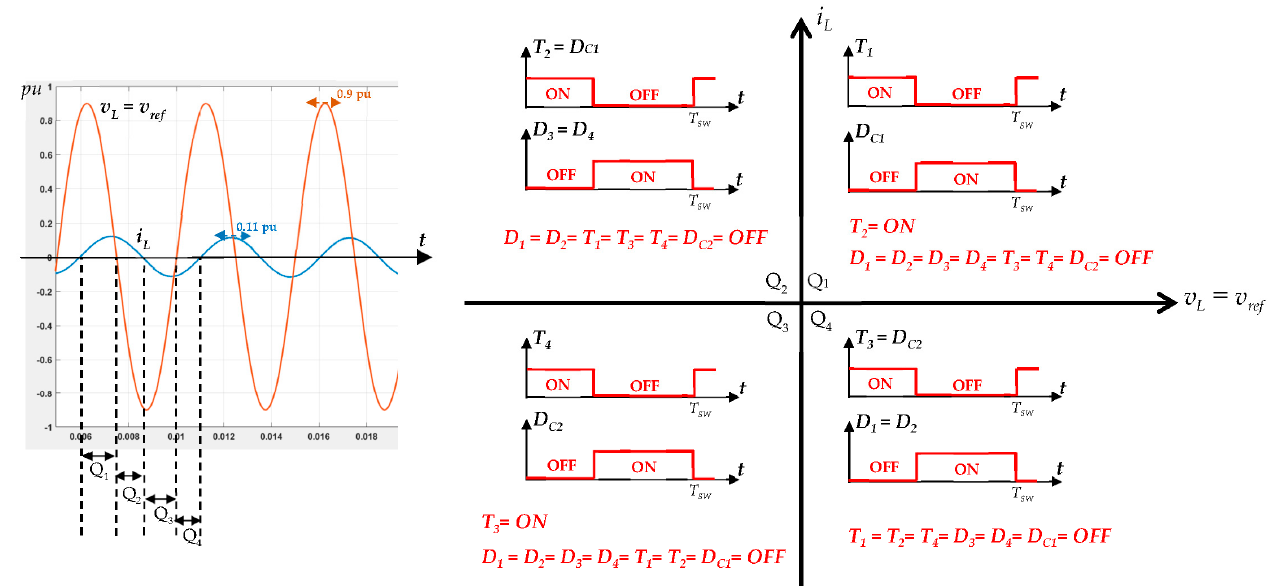
Figure 10. NPC switches states depending on load voltage/current characteristics.